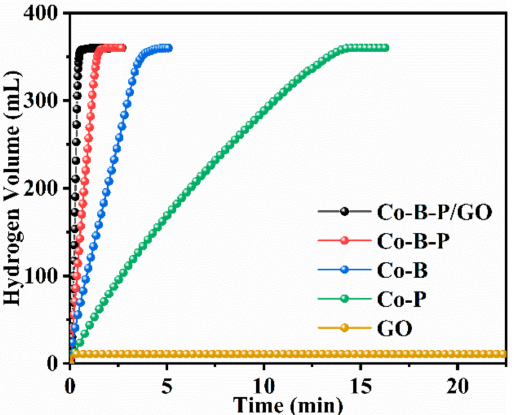
Figure 7. Hydrogen volume versus time for GO, Co-P, Co-B, Co-B-P, and Co-B-P/rGO (batch system,